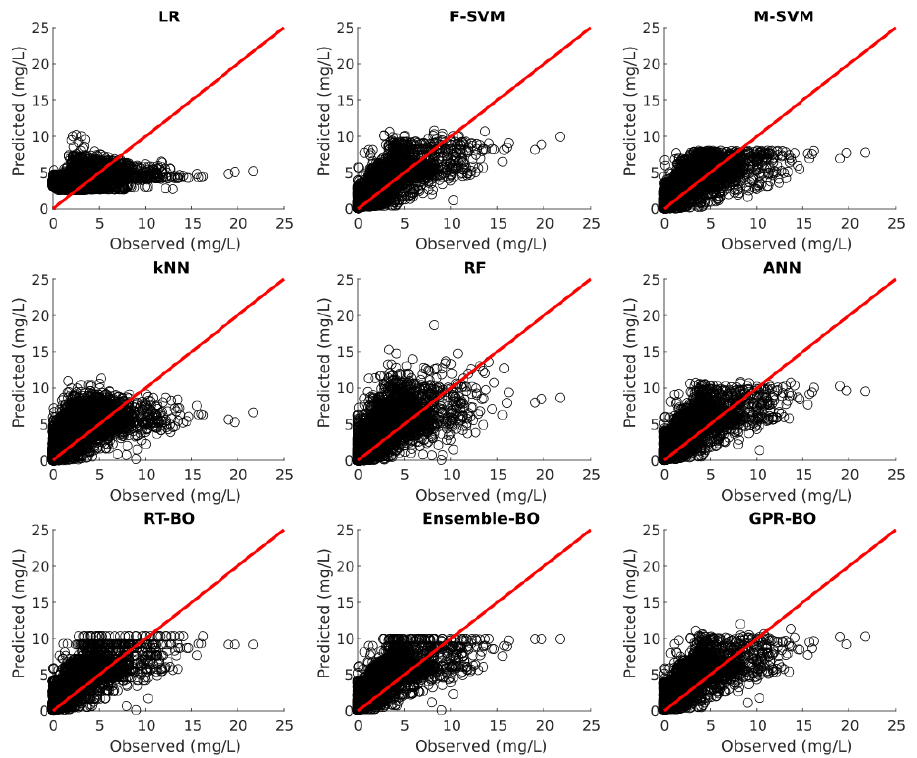
ML algorithms. rithms.